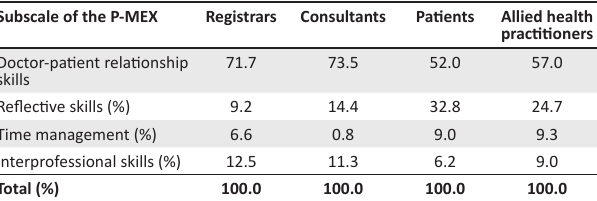
TABLE 4: Standardised scores for rankings of professionalism items by the subscales of the Professionalism Mini-Evaluation Exercise Questionnaire. Subscale of the